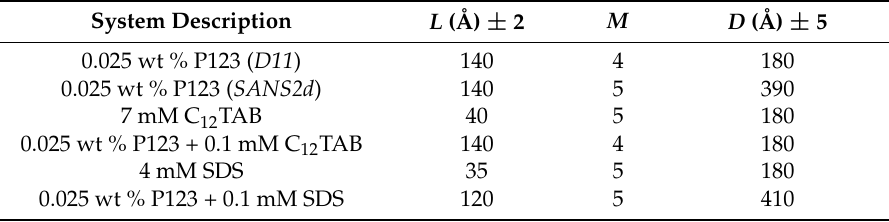
Table 1. Fit (multilayer model) parameters to the scattering data from foams stabilised by Pluronic P123, small molecule surfactants and their mixtures at concentrations below their CMC or mixed CMC. L : surfactant and/or polymer layer thickness, M : number of layers and D : spacing between the surfactant